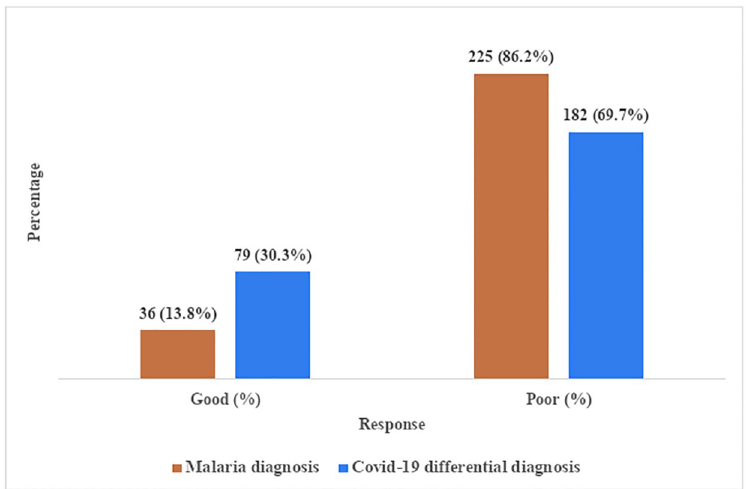
Fig 2. Overall practice score of primary healthcare workers on malaria diagnosis and COVID-19 differential